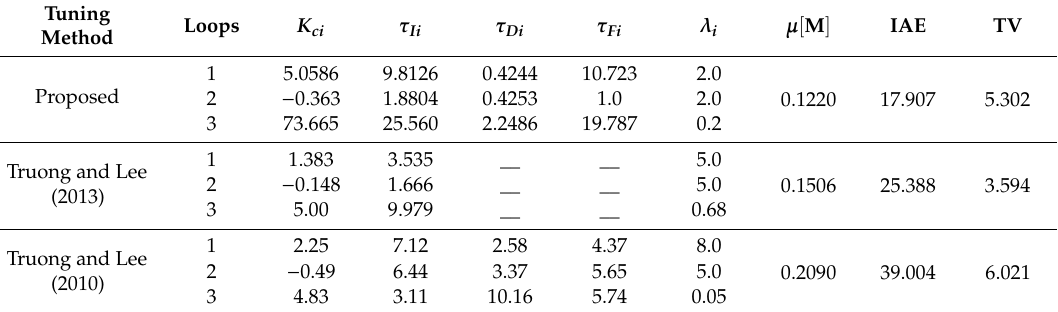
Table 9. Controller parameters and resulting performance indices for the OR column.